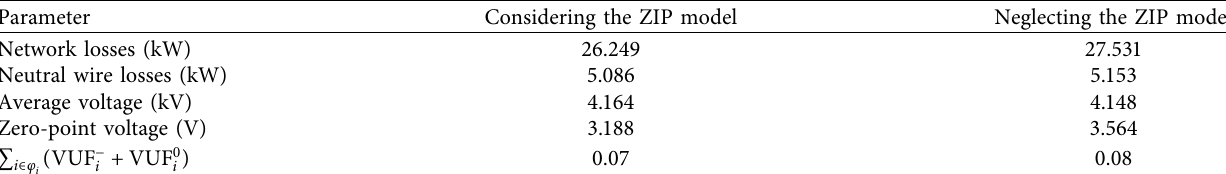
Table 7: Evaluation of the ZIP load model on the results of the proposed optimization problem in case VI. Parameter Considering the ZIP model Neglecting the ZIP